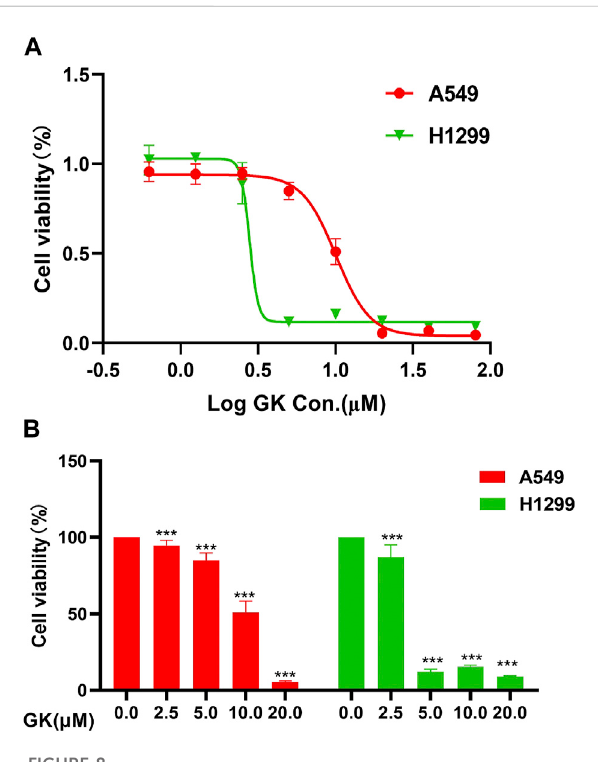
FIGURE 8 GK inhibits the proliferation of A549 and H1299 cells. (A) Growth curves obtained in proliferation (CCK-8) assays in the indicated A549 and H1299 cells. (B) Statistical analysis of the CCK-8 of the expressed A549 and H1299 cells.